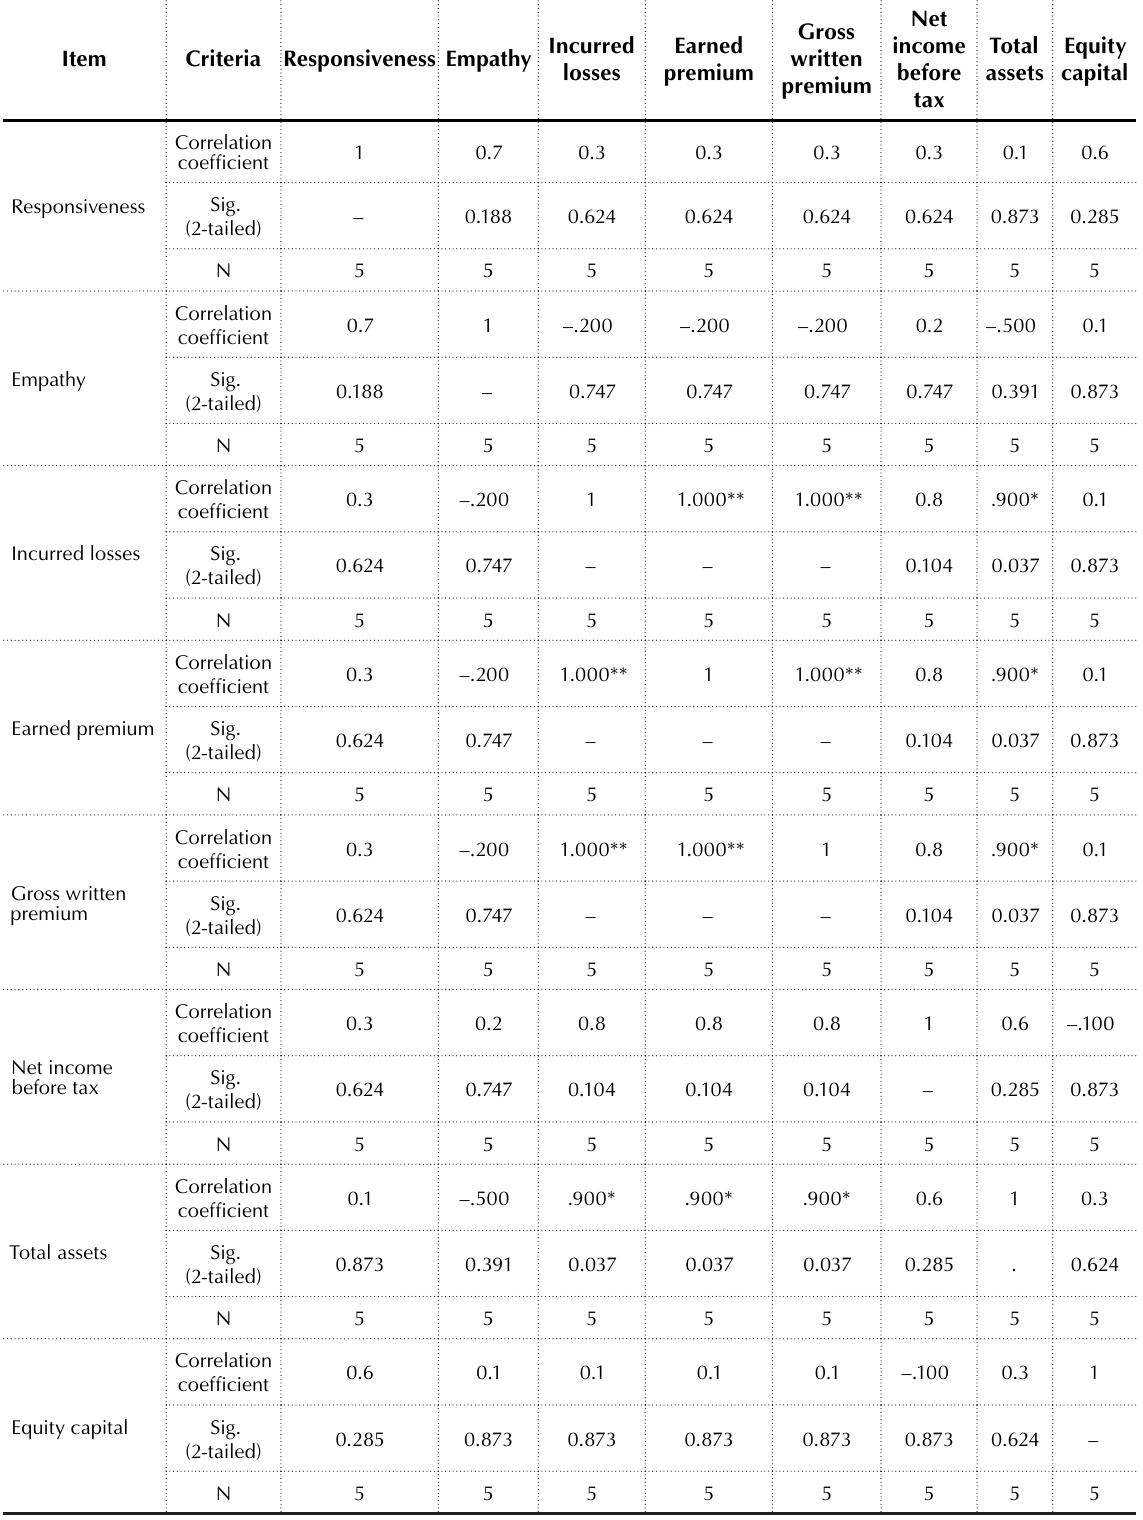
Table A7. Correlation between SERVQUAL and absolute average amount of profitability